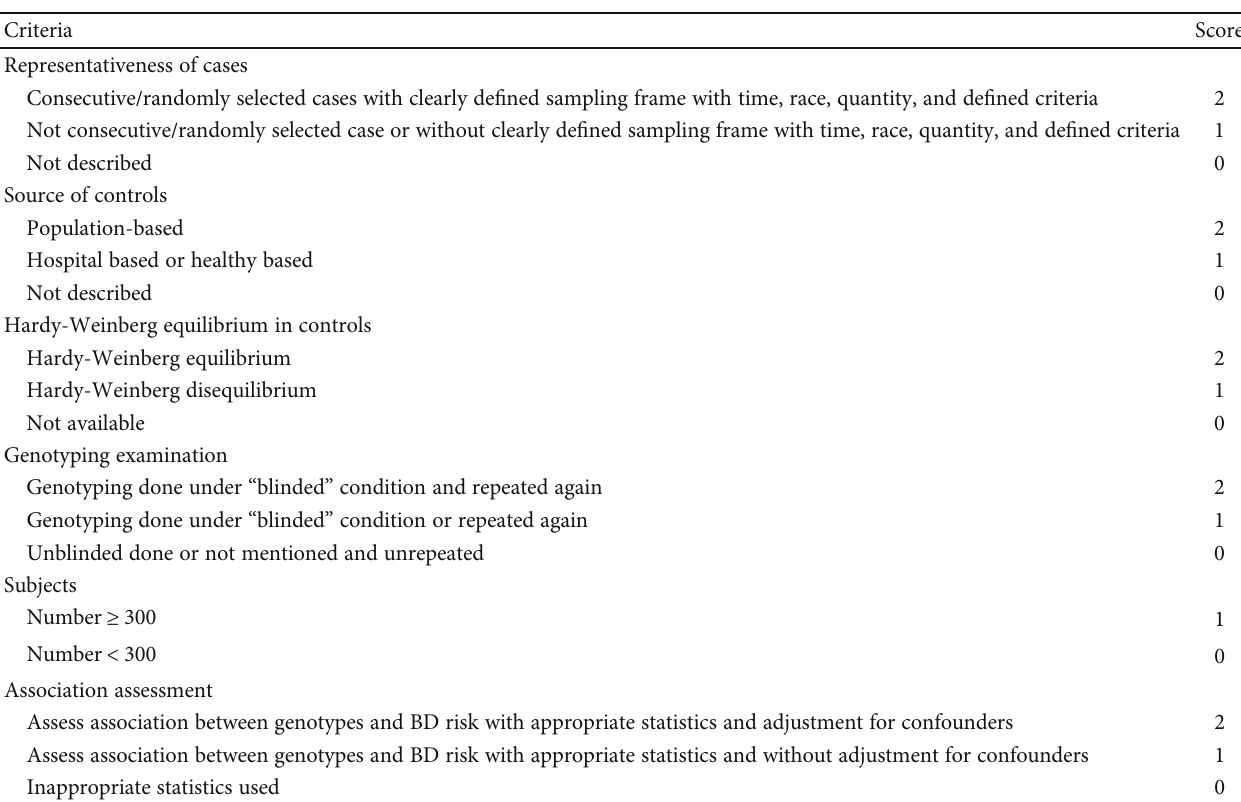
Table 1: Scale for quality